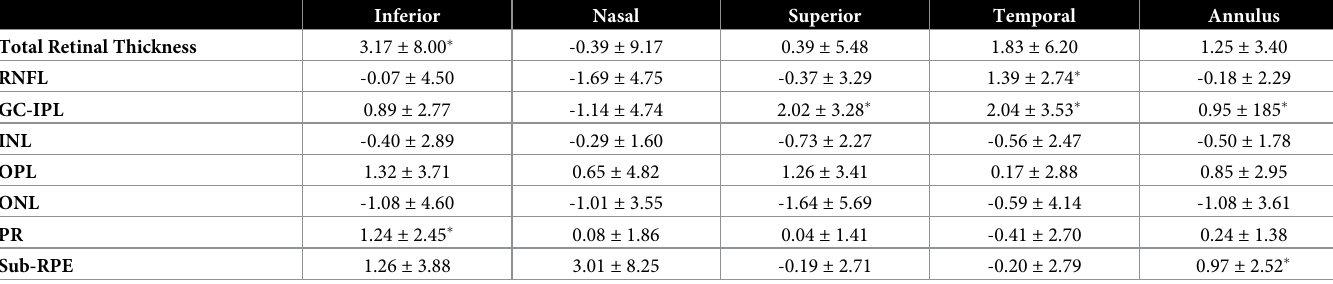
Table 3. Subgroup analysis of eyes with BCVA � 20/40.